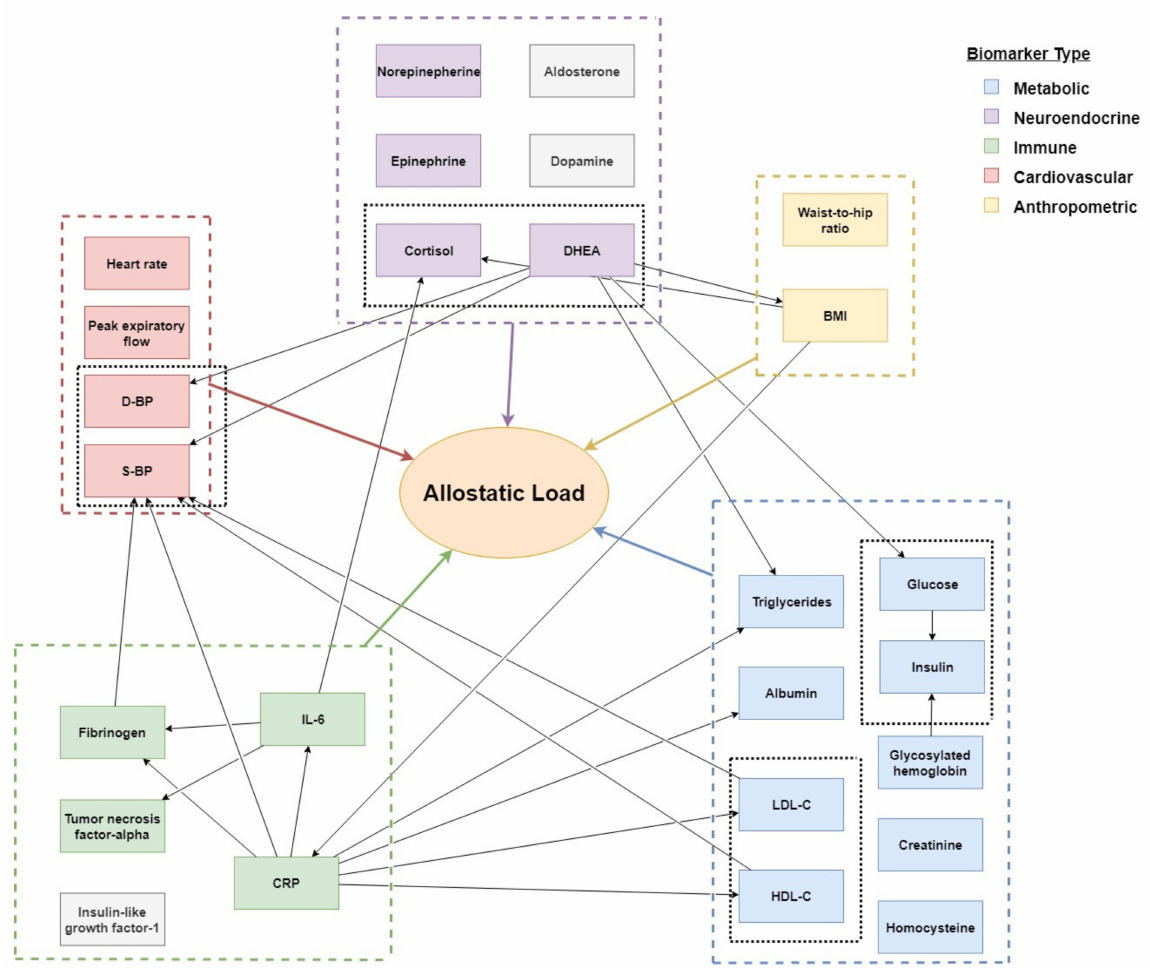
Figure 5. Although not all found studies provided data that could be used in a Bayesian network, based on the collected body of literature an additional (theoretical) model of allostasis in the elderly could nevertheless be constructed (see Table 4 as well). It shows that the biomarker clusters proposed by Juster et al. [1] seem to be valid in elder populations, while for example the cortisol/DHEA ratio [66,67] gains more prominence (as compared to the mathematical (Bayesian) model). The latter finding may call for additional studies to further disclose the actual contribution of such biomarkers in the overall health of